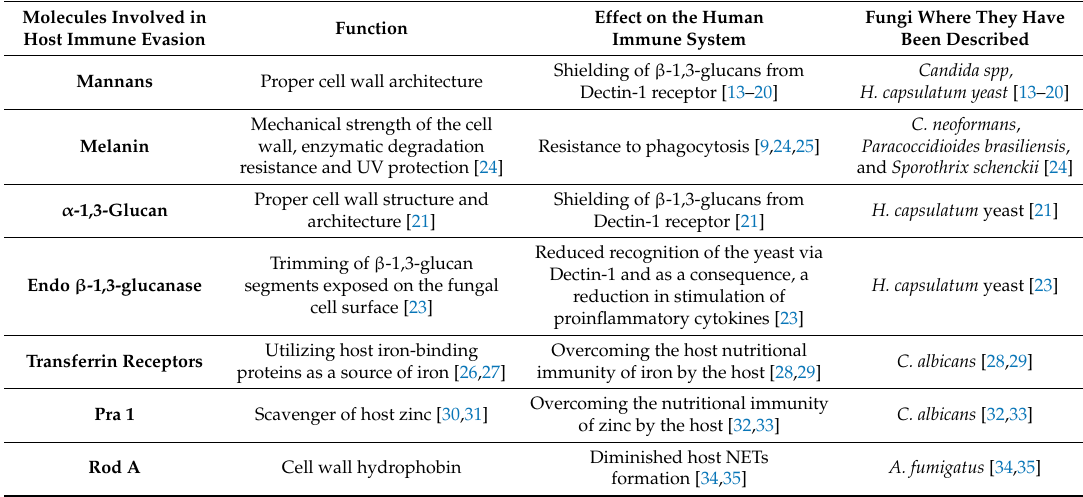
Table 1. Molecules involved in host immune evasion. The table summarizes the different molecules associated to host immune evasion. Their function and effect on the immune system are briefly